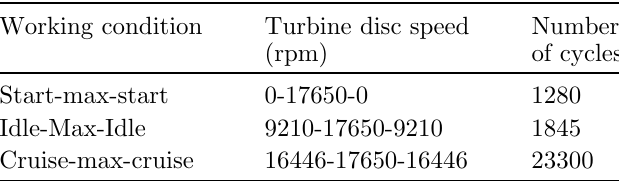
Table 4. Load spectrum of turbine disc at 750 h [21].